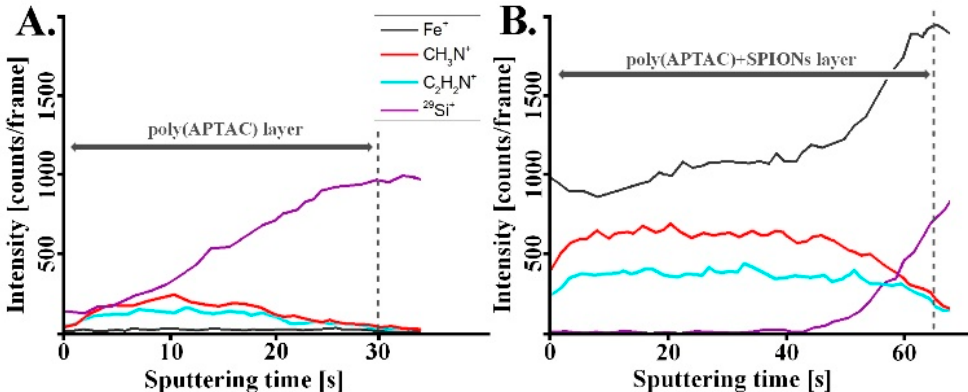
Figure 5. Secondary ion mass spectrometry (SIMS) spectra for polymeric brushes: ( A .) bare poly(APTAC), ( B .) poly(APTAC)+SPIONs.